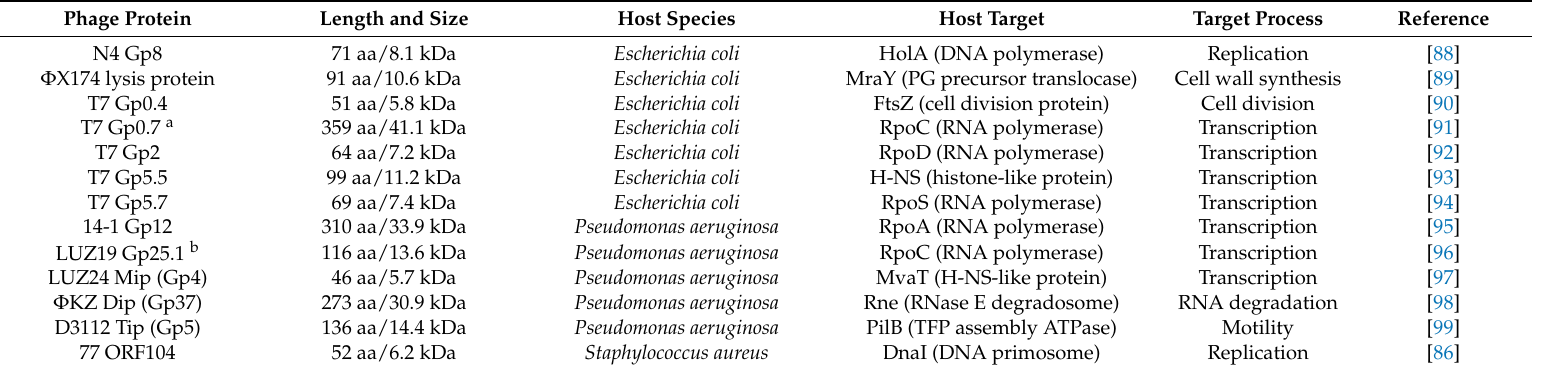
Table 1. Examples of vulnerable bacterial targets by phage